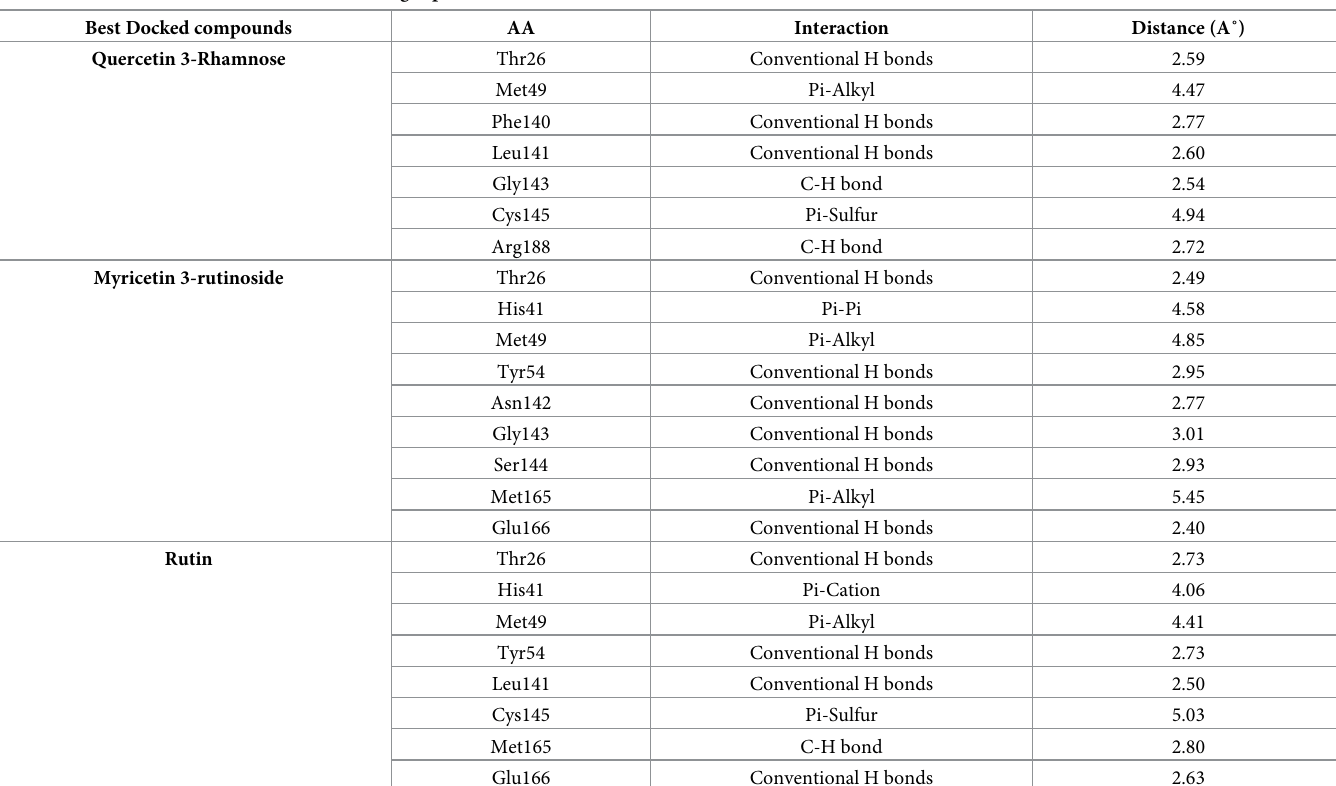
Table 2. Interaction of the best hits of the docking experiments. Best Docked compounds AA Quercetin 3-Rhamnose